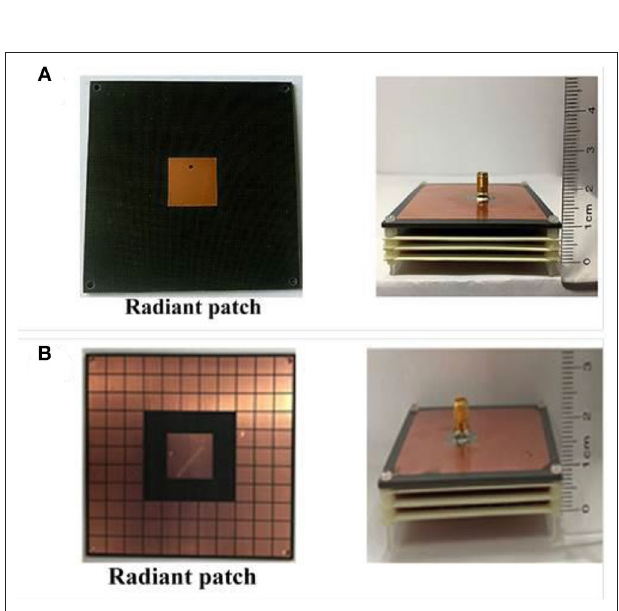
FIGURE 8 | Photograph of the fabricated antenna. (A) Type I antenna. (B) Type II antenna.